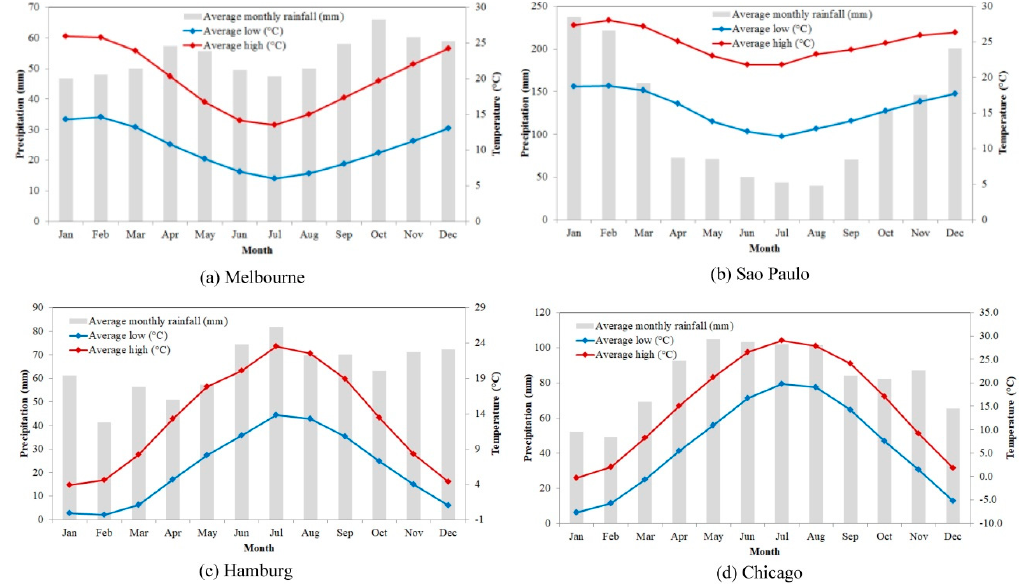
Figure 2. Climatic characteristics of the four selected cities (Data source: World Meteorological Organisation).